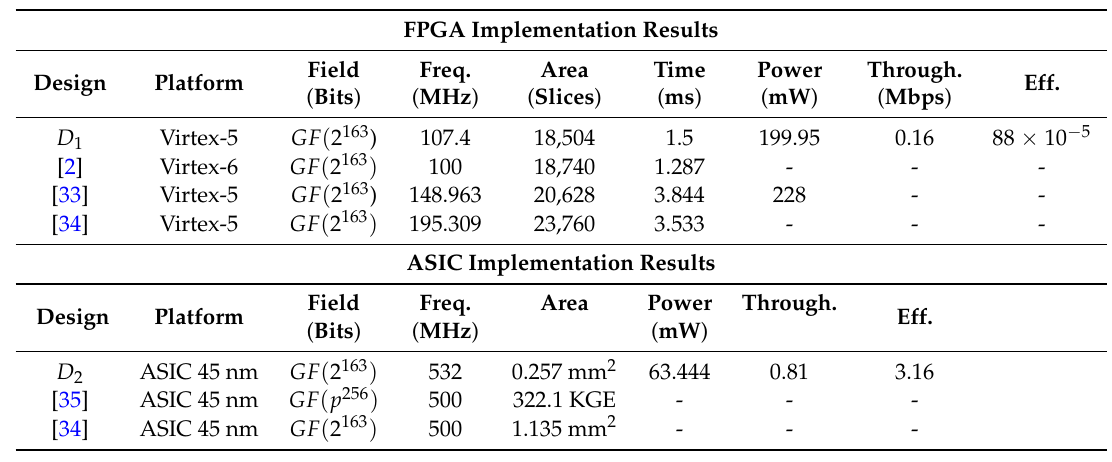
Table 9. Results Comparison of different ECDSA